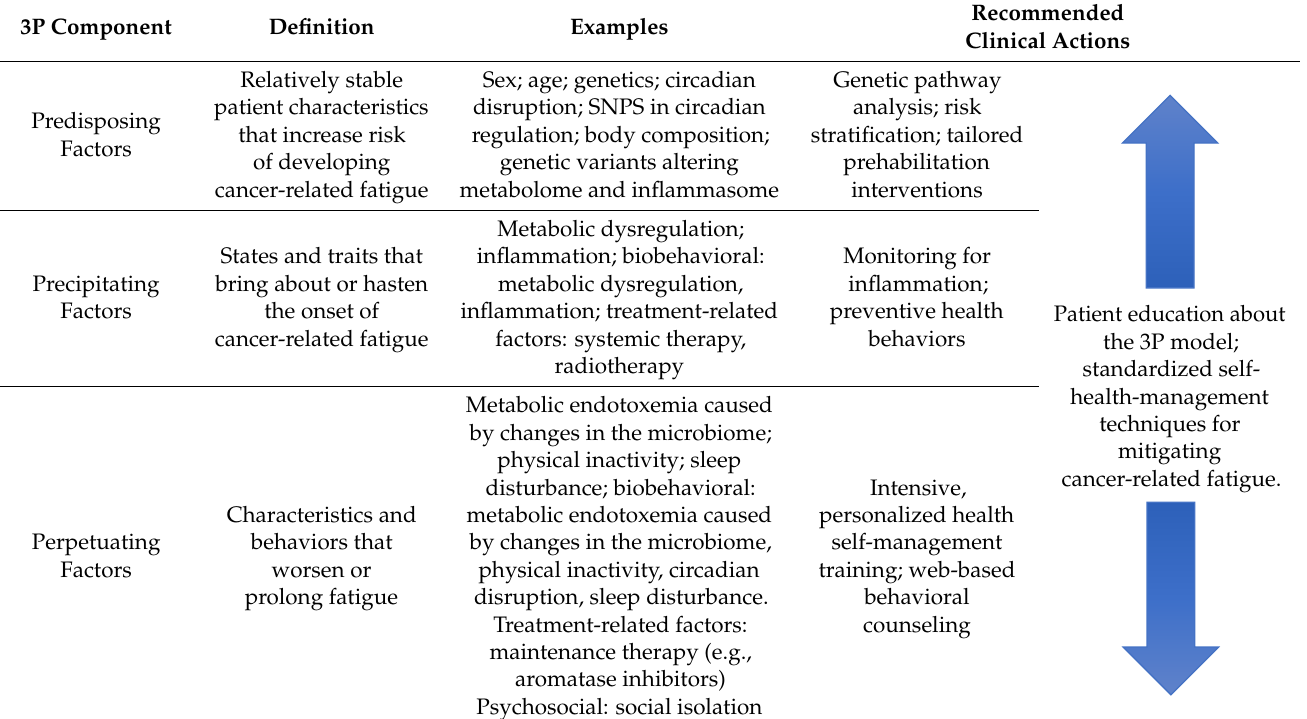
Table 1. 3P definitions, examples, and recommended clinical actions.